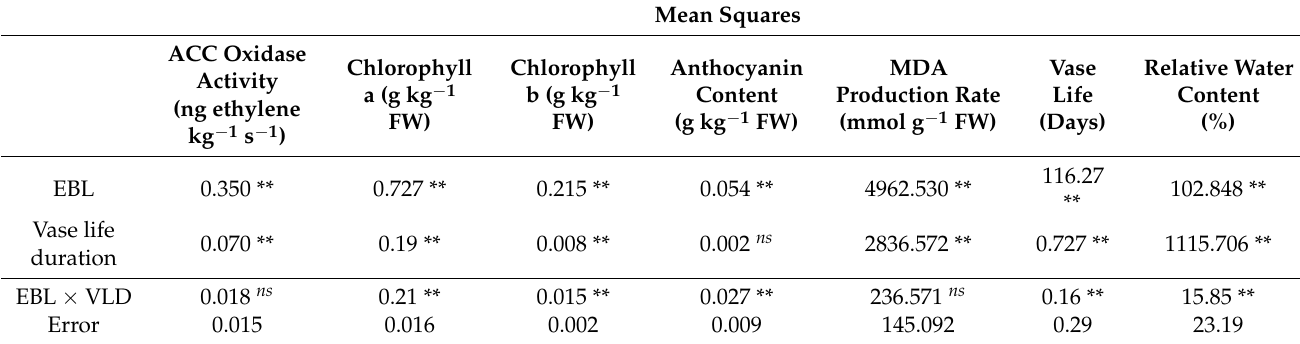
Table 1. One-way ANOVA for the effect of 24-epibrassinolide (EBL) and vase life duration (VLD) on ACC oxidase activity, chlorophylls (Ch) content, anthocyanin content, MDA production rate, vase life, and relative water content of lisianthus cut flowers.